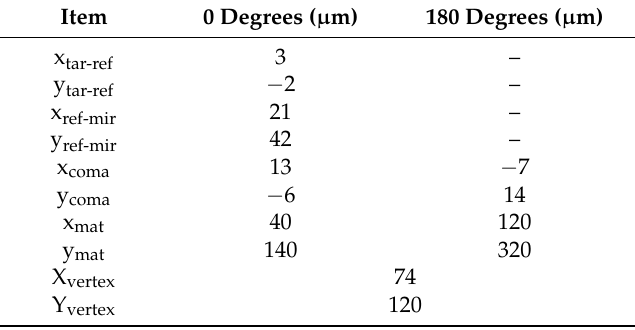
Table 1. Results of the vertex position measurement. x tar-ref , y tar-ref are displacements between the target center and reference cylinder center in x, y directions; x ref-mir , y ref-mir are displacements between the reference cylinder center and mirror center in x, y directions.